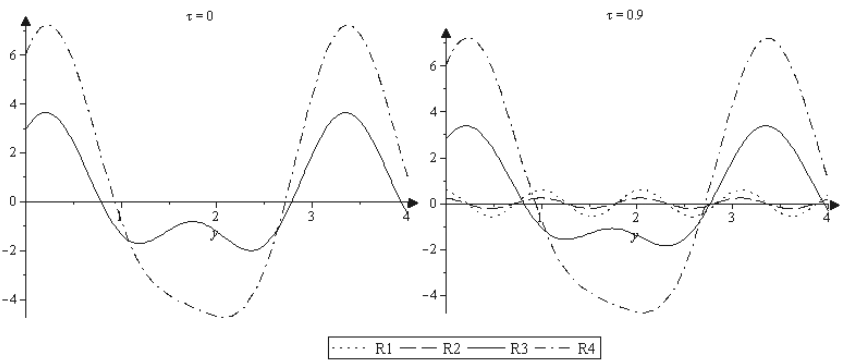
Figure 1. Graphs of example 1 functions R 1 , R 2 , R 3 , R